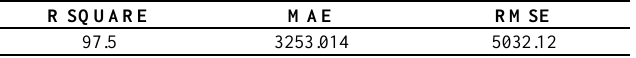
Table 6. The obtained error values in MLP model using the factors in previous studies.